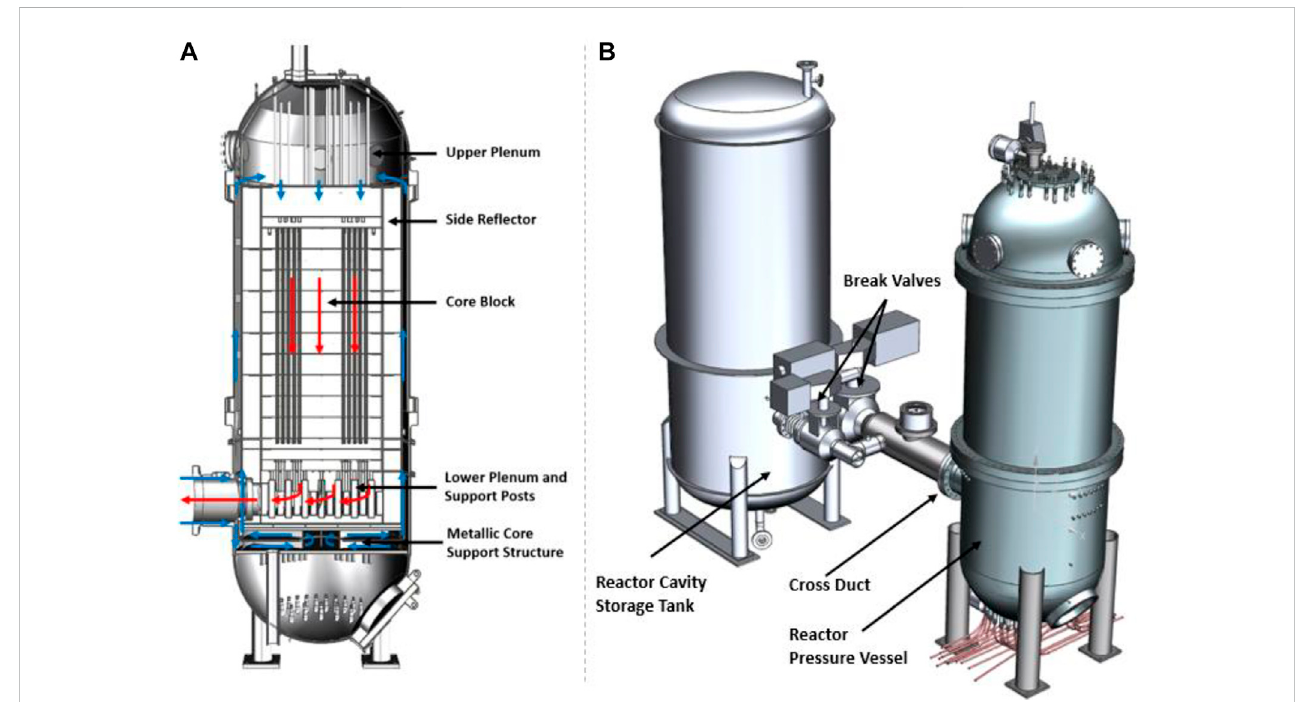
FIGURE 1 (A) Section view of the HTTF RPV showing the helium fl ow path; (B) HTTF system CAD